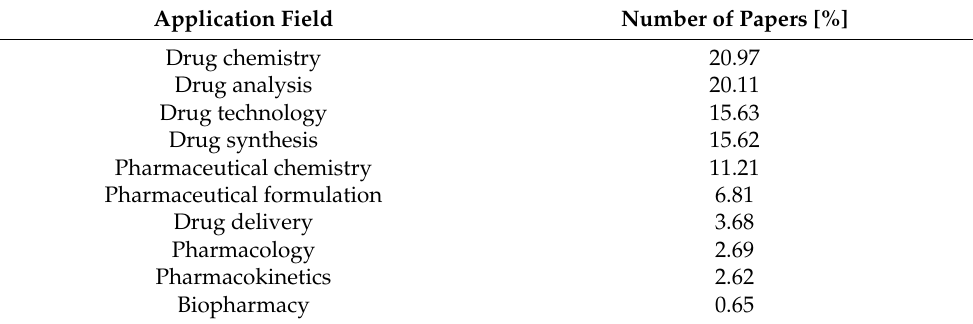
Table 1. Representation of selected applications of Langmuir balance in studies performed for development of drugs found in the available bibliography in the decade 2012–2021.